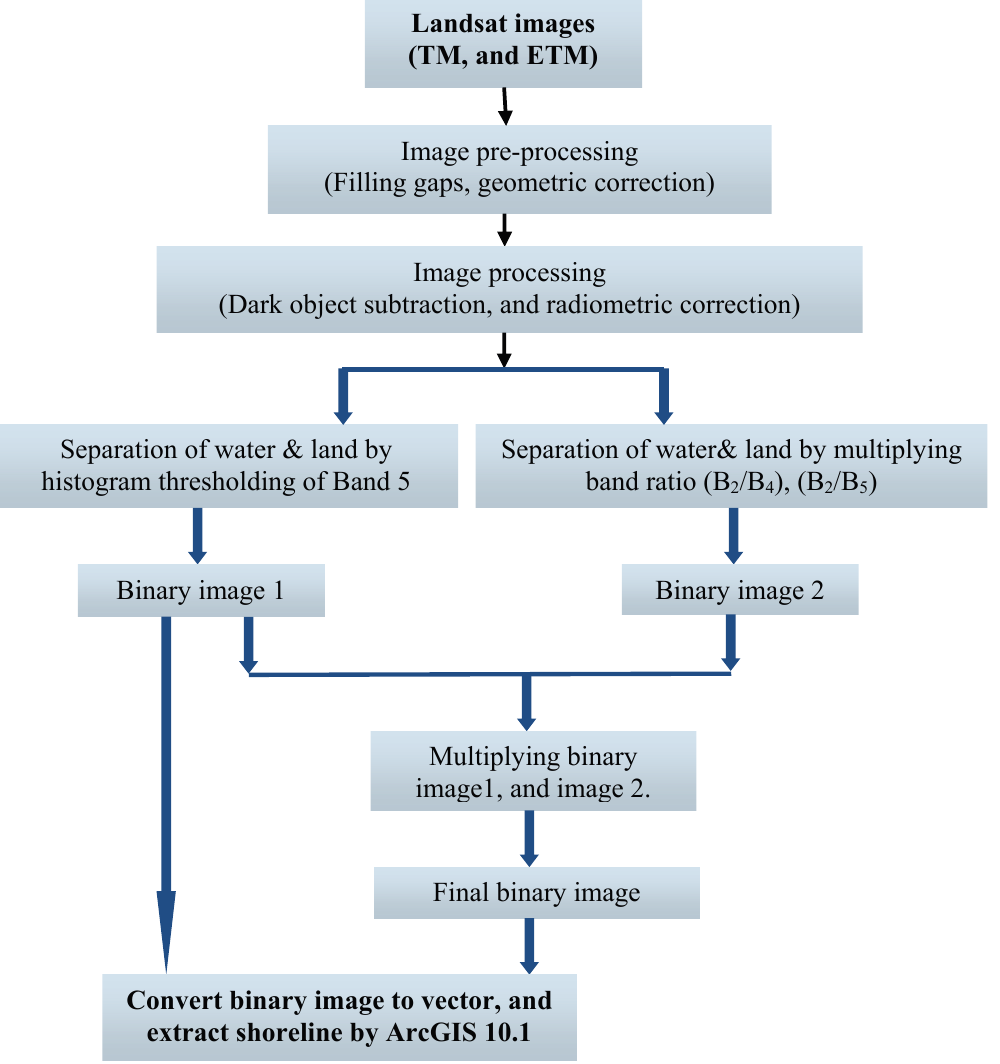
Figure 4. Flow chart for extracting coastline from Landsat images using threshold histogram, and a combination of threshold histogram with band